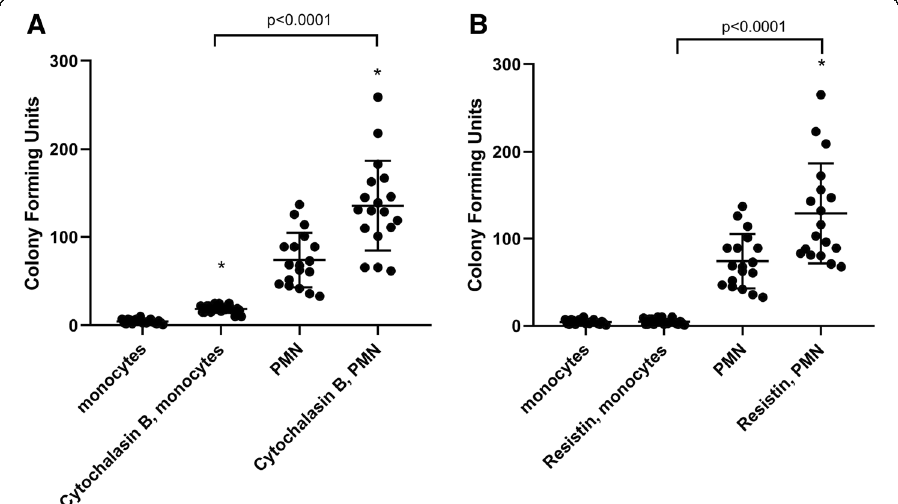
Fig. 5 Comparison of the effects of a cytochalasin and b resistin on the bacterial killing capacity of P. aeruginosa by primary human monocytes versus PMN (neutrophils). Cytochalasin significantly impairs bacterial killing by both primary PMN ( P =0.0009) and primary monocytes ( P <0.0001). Resistin does not affect bacterial killing by monocytes ( P =0.91) but significantly impairs killing by neutrophils ( P =0.003). n =21 for monocytes and n =18 for neutrophils. Asterisk denotes statistical significance ( P